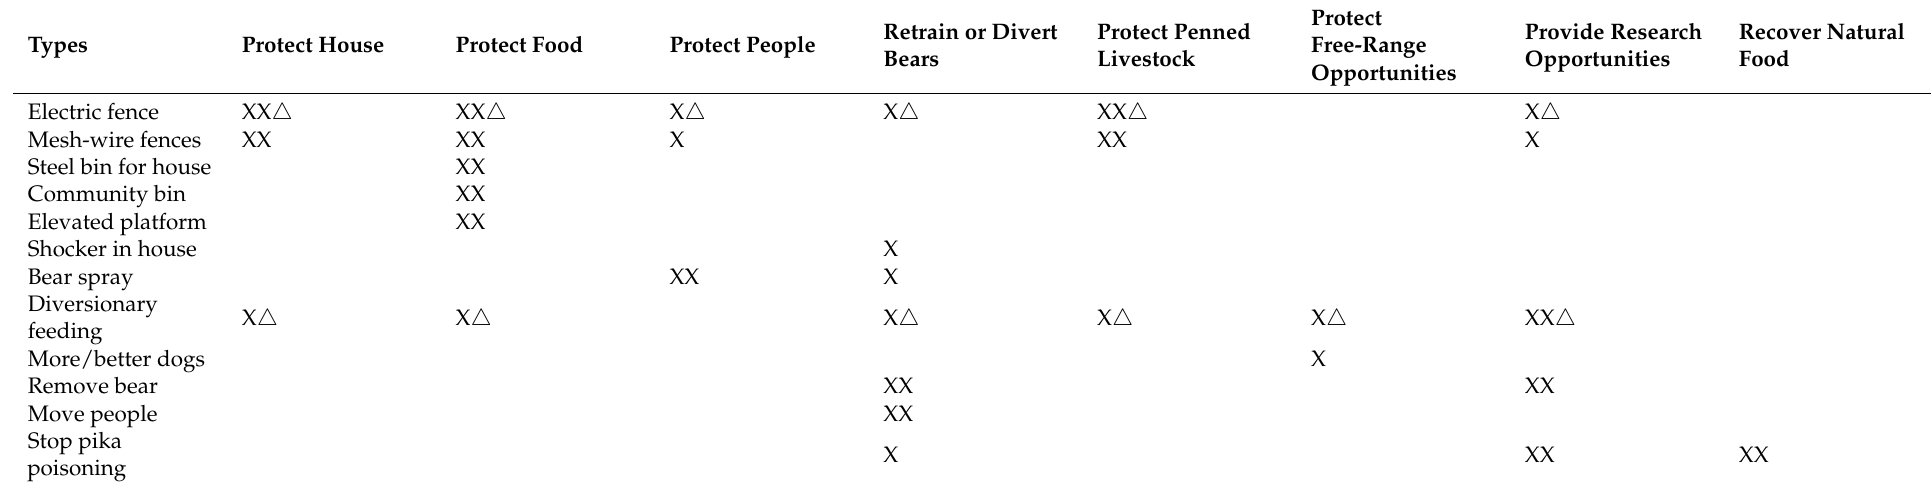
Table 4. Participants were presented with a matrix of issues related to bear conflicts (columns) versus potential solutions (rows) and ranked the solutions as likely effective (XX), potentially moderately effective (X), or not likely to address the problem (blank). After this ranking, participants chose the solutions that were most likely to solve the issues ( (cid:52)